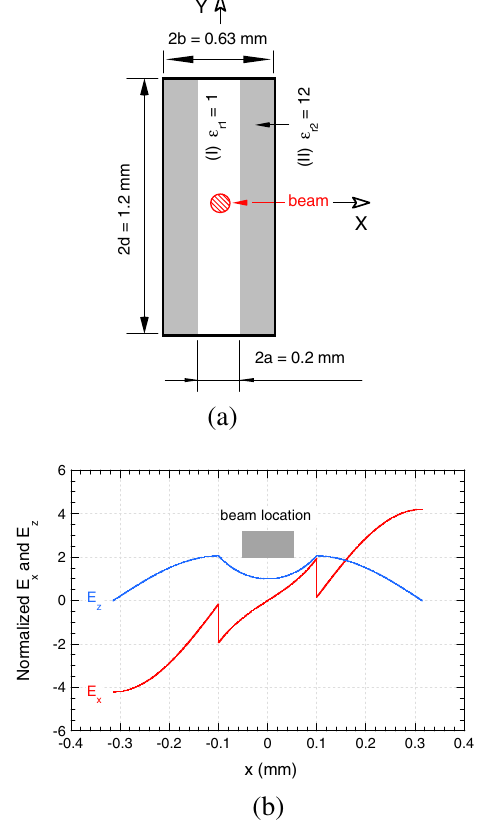
for LSM operating z 21 (cid:3) 14 042 = m and (cid:2)g (cid:3) z